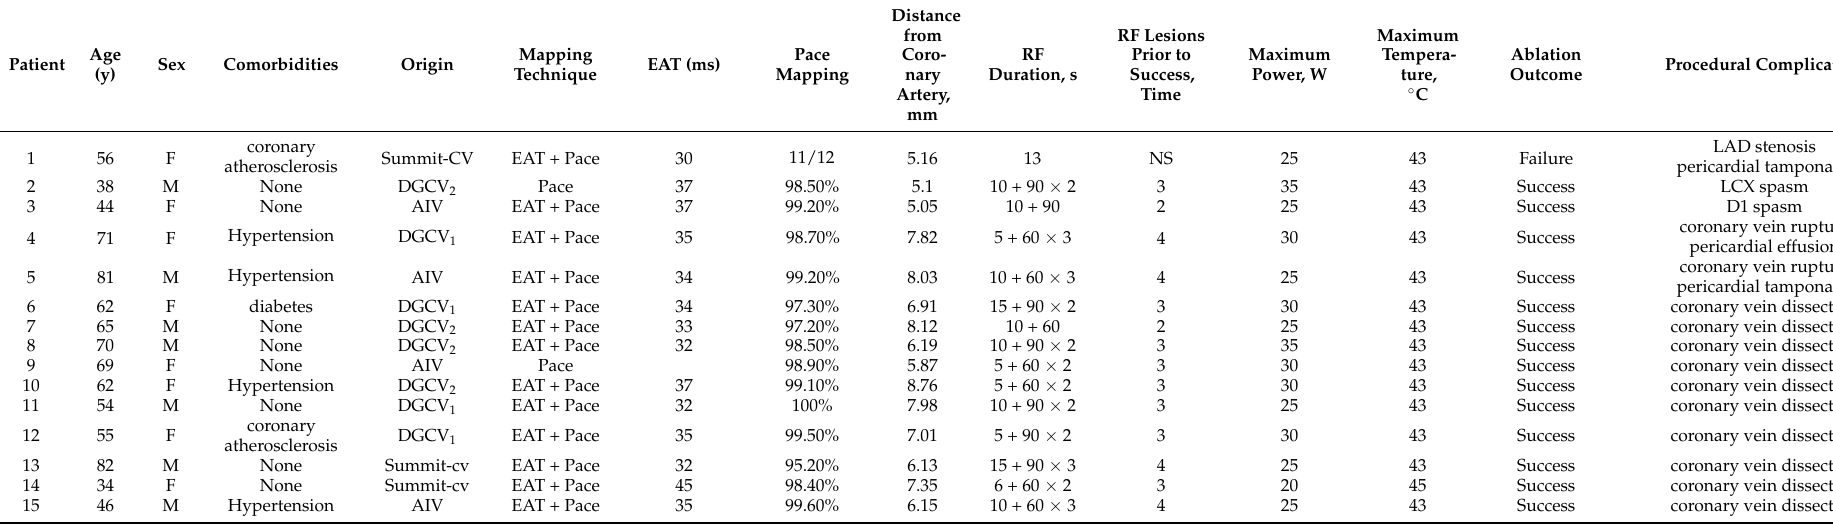
Table 6. The procedural